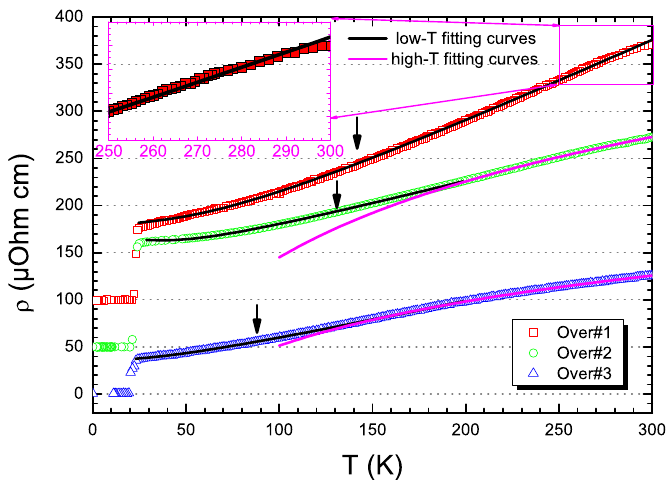
Figure 3. (Color online) Resistivity curves for three selected over-doped SLCO samples. In the inset (magenta box), a zooming-out of the high-temperature regime for the Over (cid:93) 1 sample. For all curves, the low temperature regime has been fitted by using Equation (1) (black curves), while the high temperature regime has been fitted for the Over (cid:93) 2 and Over (cid:93) 3 sample by a logarithmic behavior (magenta curves). Arrows indicate the temperatures at which, at low temperatures, the resistivity curves are no longer purely linear, namely T L . Data are shifted 50 µ Ohm · cm for